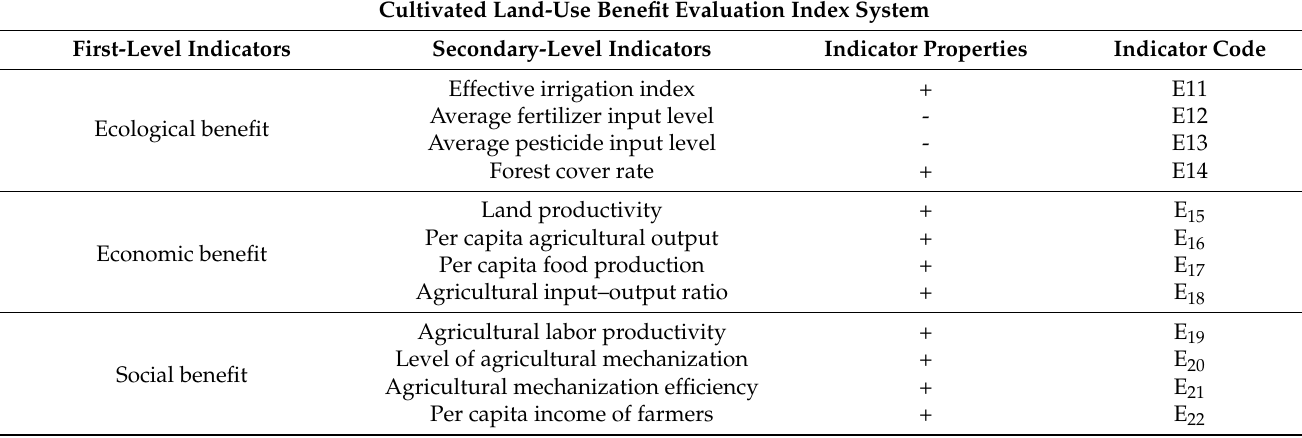
Table 1. Cultivated land-use benefit evaluation index